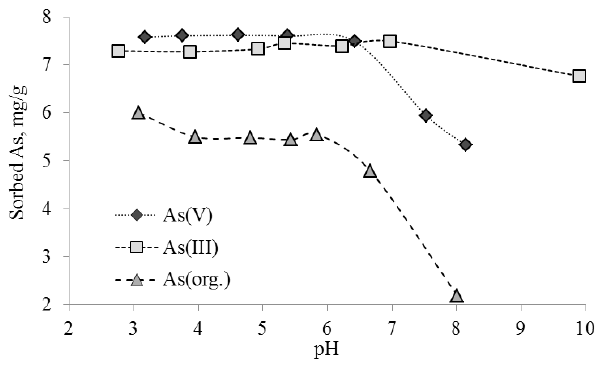
Figure 5: Influence of pH on removal of arsenic using Fe-modified peat as sorbent, sorption time 24 h at room temperature, initial concentration of As – 100 mg L -1